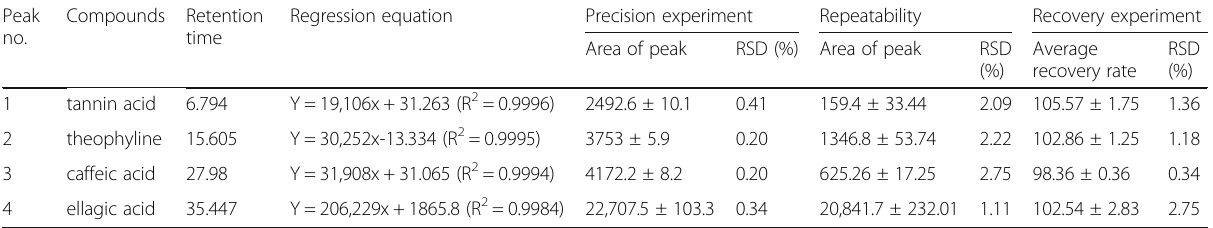
Table 2 Method validation for the quantitative determination of four compounds using RP-HPLC Peak